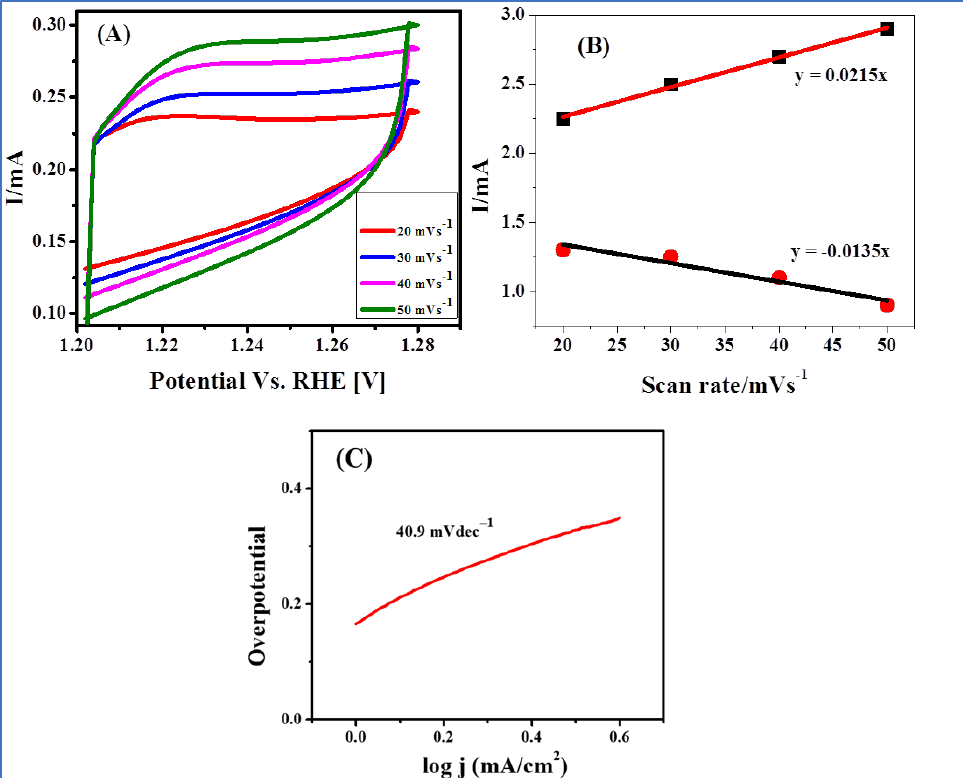
Figure 5. ( A ) CVs of NiCo(OH) 2 -LDH/FTO electrocatalyst performed in the non-Faradaic region at various scan rates from 10 to 50 mVs − 1 ; ( B ) plot of anodic and cathodic currents against scan rate for NiCo(OH) 2 -LDH/FTO electrocatalyst; ( C ) Tafel plot based on the data (during the OER) obtained from LSV for the NiCo(OH) 2 /FTO electrocatalyst.